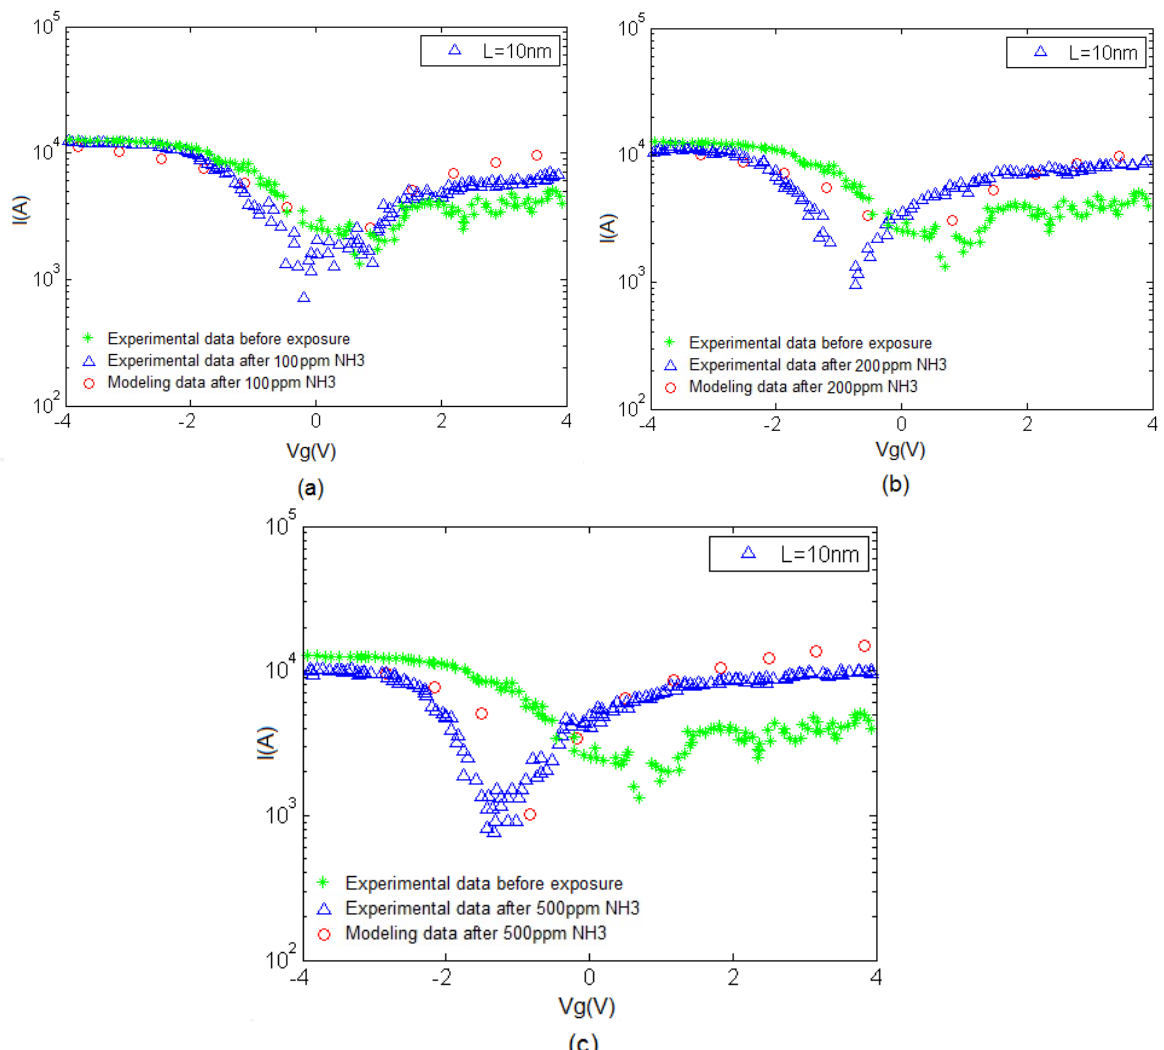
Figure 6. CNT I–V characteristics before and after exposure to NH F = 100 ppm; ( b ) F = 200 ppm; ( c ) F = 500 ppm showing larger conductivity values in higher gas